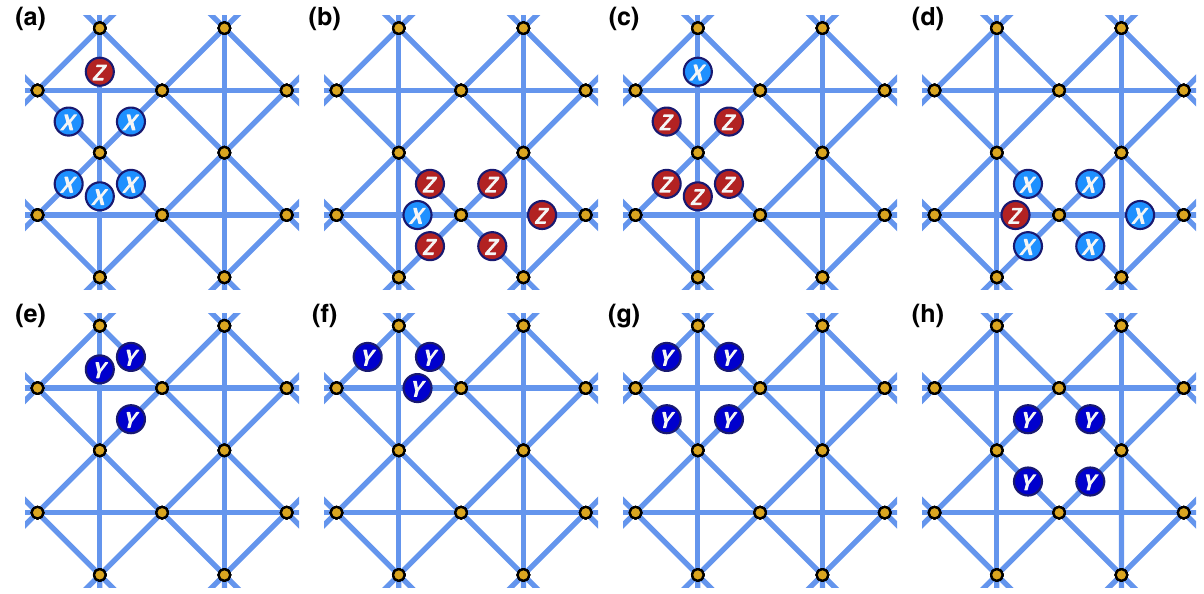
FIG. 2. The terms of the checkerboard-lattice code. (a),(b) The two inequivalent Hamiltonian terms of a fiducial bosonization H 0 of the line graph of the square lattice. The line graph is shown in light blue, with brown circles to indicate the vertices. Note that there is no vertex in the middle of the square plaquettes where the horizontal and vertical edges cross. The constituent single-qubit Pauli operators of each term are indicated in color-coded and labeled circles in the center of each edge. For ease of view, we indicate the identity by the absence of a label, and for the two edges that cross, we have displaced the drawn symbols to make it clear which edge they belong to. (c),(d) The two inequivalent terms of a second fiducial bosonization H 1 obtained by flipping all single-qubit Paulis. All terms in H 0 commute with all terms in H 1 . (e)–(h) Four additional stabilizer terms per unit cell. Combining both Hamiltonians and the four stabilizers gives a frustration graph consisting of two independent copies of the line graph of the square lattice, and this produces two exact logical qubits, shown in Fig.